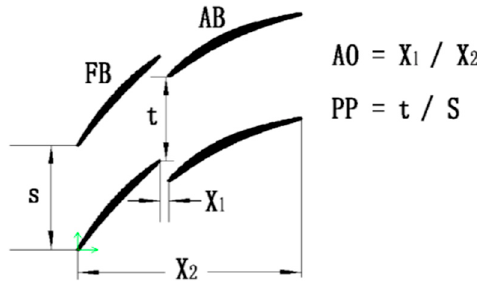
Figure 1. Schematic of a tandem blade.